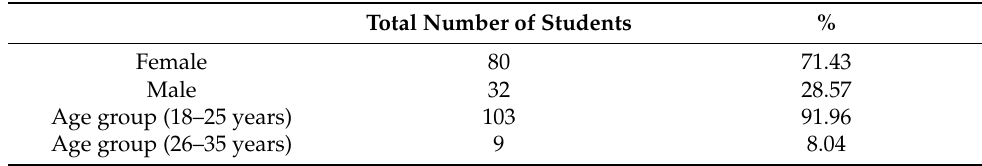
Table 1. Sociodemographic characteristics of